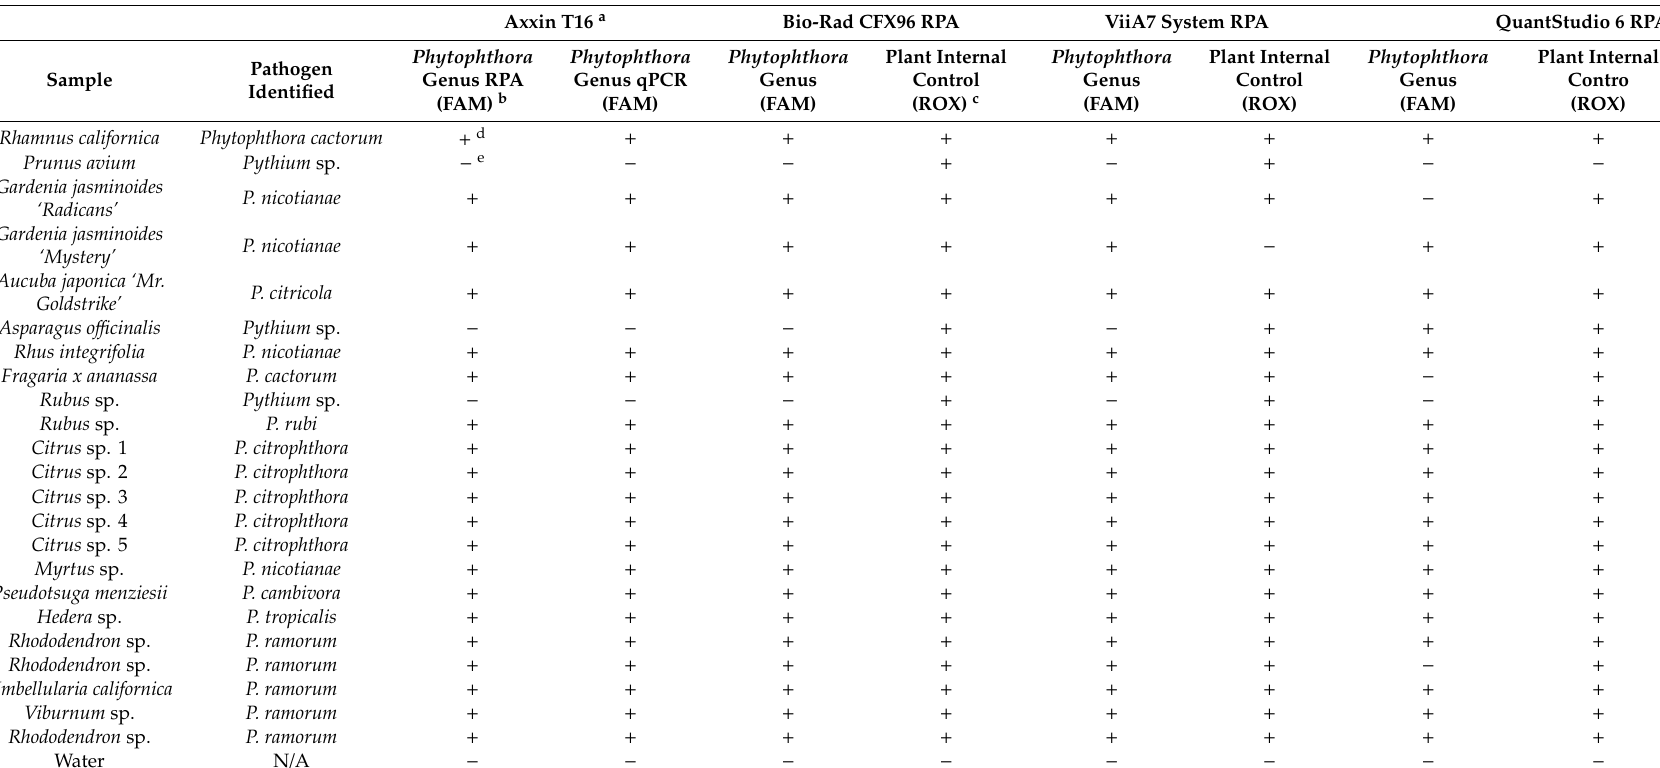
Table 3. Blind validation panel used to evaluate the preformulated lyophilized recombinant polymerase amplification (RPA) reaction and commercially available RPA reactions compared to the results of qPCR assays as reported in Miles et al.